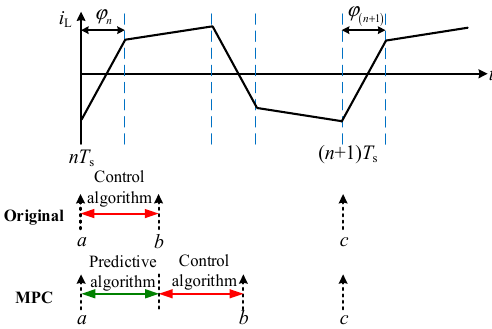
Figure 6. Model predictive control strategy of the DAB converter.